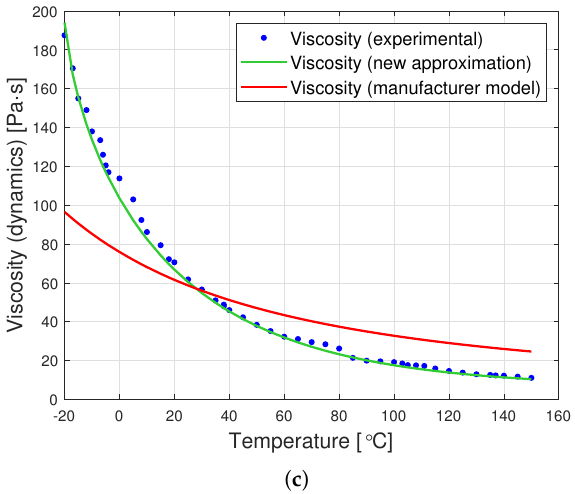
Figure 8. Graphs of dynamic viscosity for oils with nominal kinematic viscosities: ( a ) 10,000cSt, ( b ) 30,000cSt, ( c ) 60,000cSt. (universal approximation).